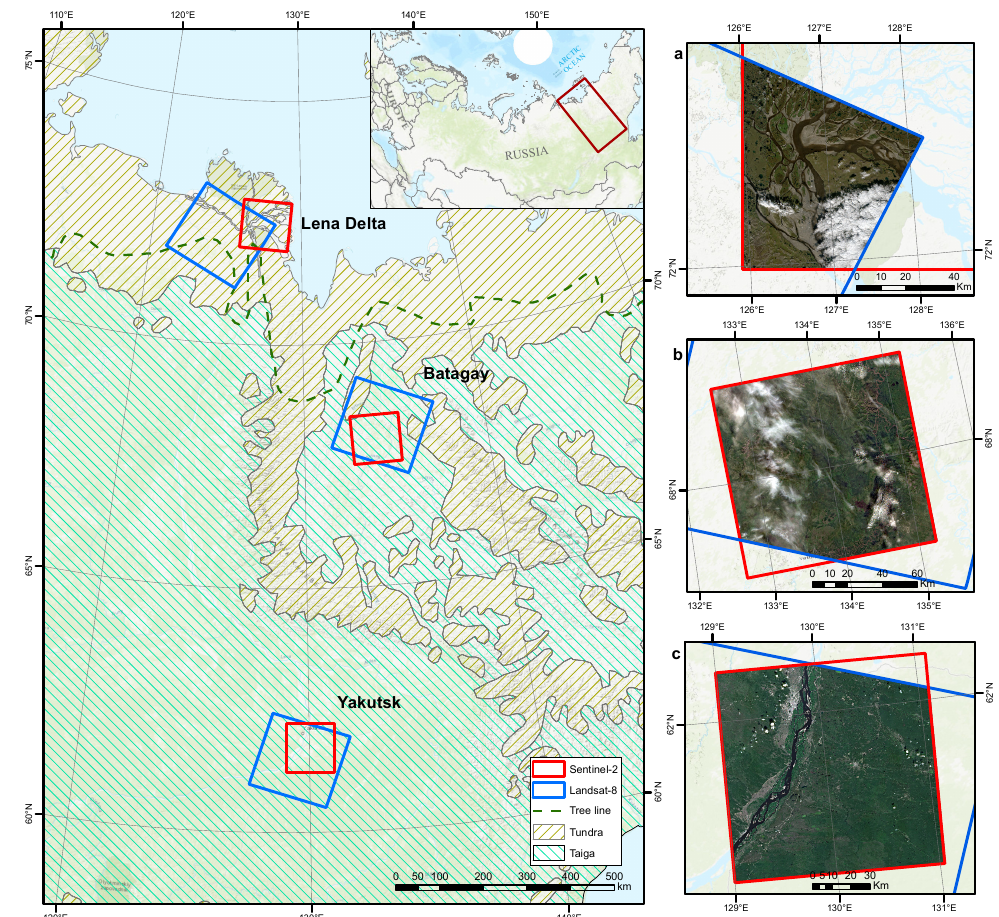
Figure 2. The three Arctic-to-Boreal study sites, Lena Delta, Batagay region, and Yakutsk region, are located along an approximate north-south transect in Eastern Siberia. The blue frames show the Landsat-8 image footprint, and the red frames show the Sentinel-2 image footprint of the same-day acquisitions used in this study. Sentinel-2 RGB composites of the overlapping area for the Lena Delta ( a ), Batagay region ( b ), and Yakutsk region ( c